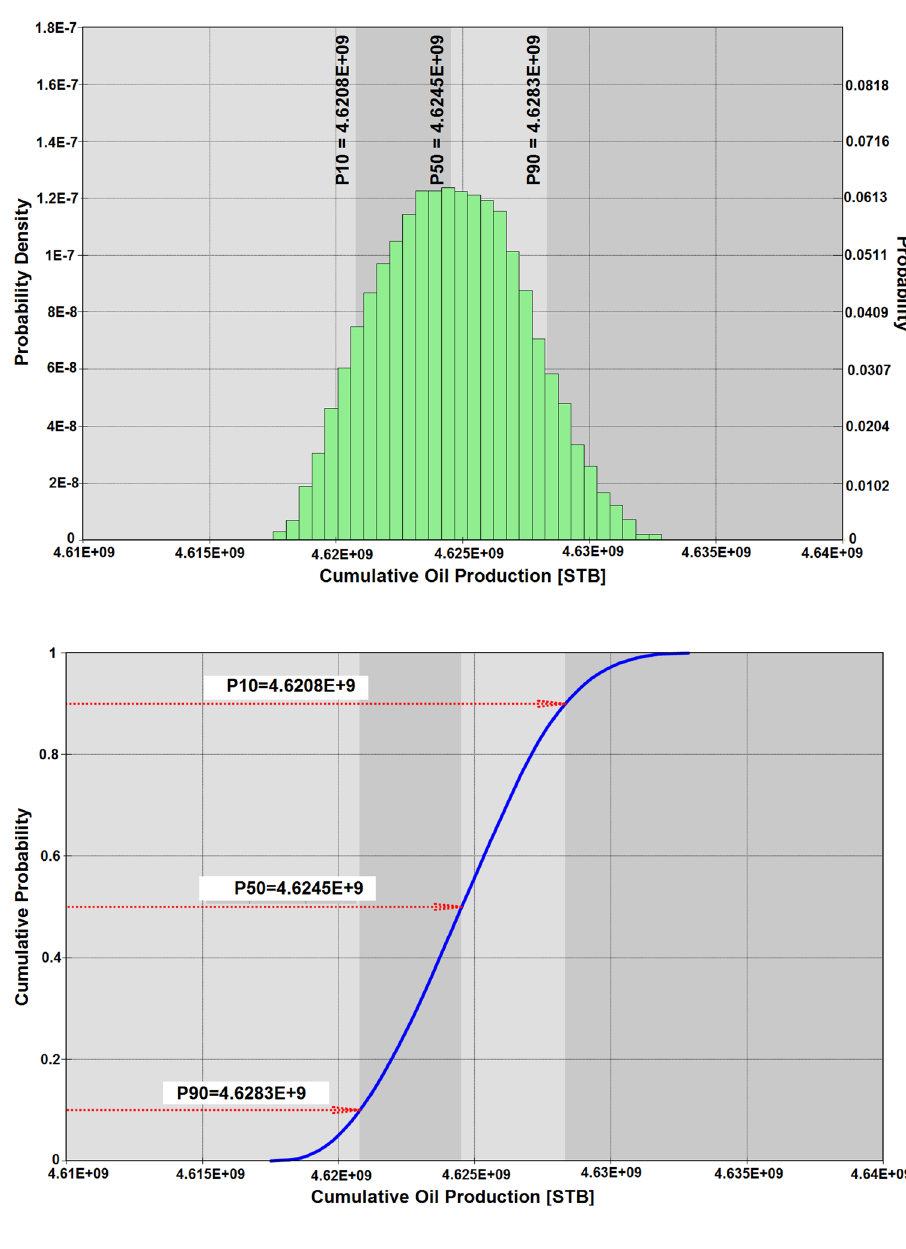
Fig. 17 Probability function distribution of reservoir flow response under production uncertainty